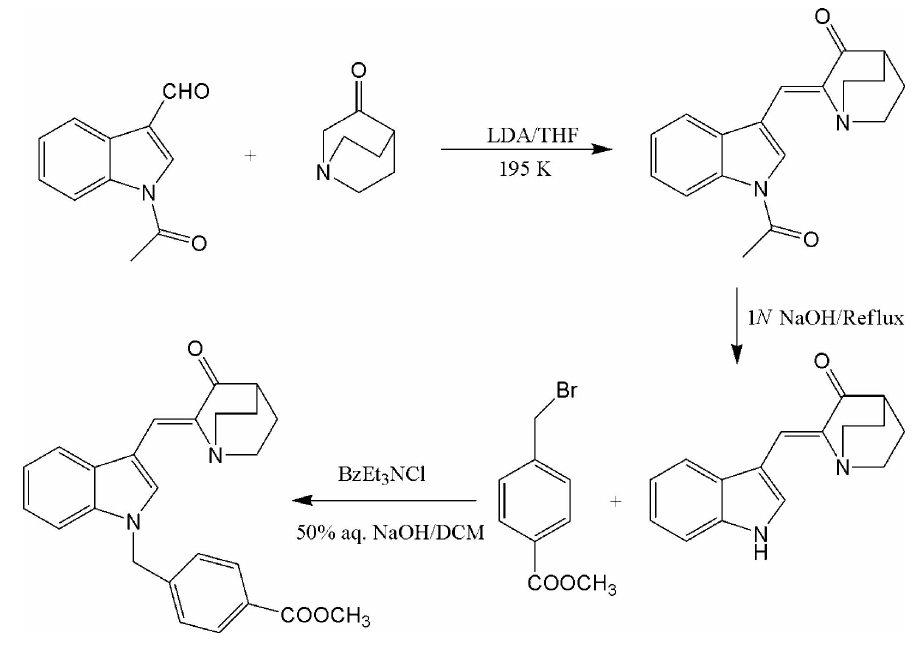
Figure 2 Reaction